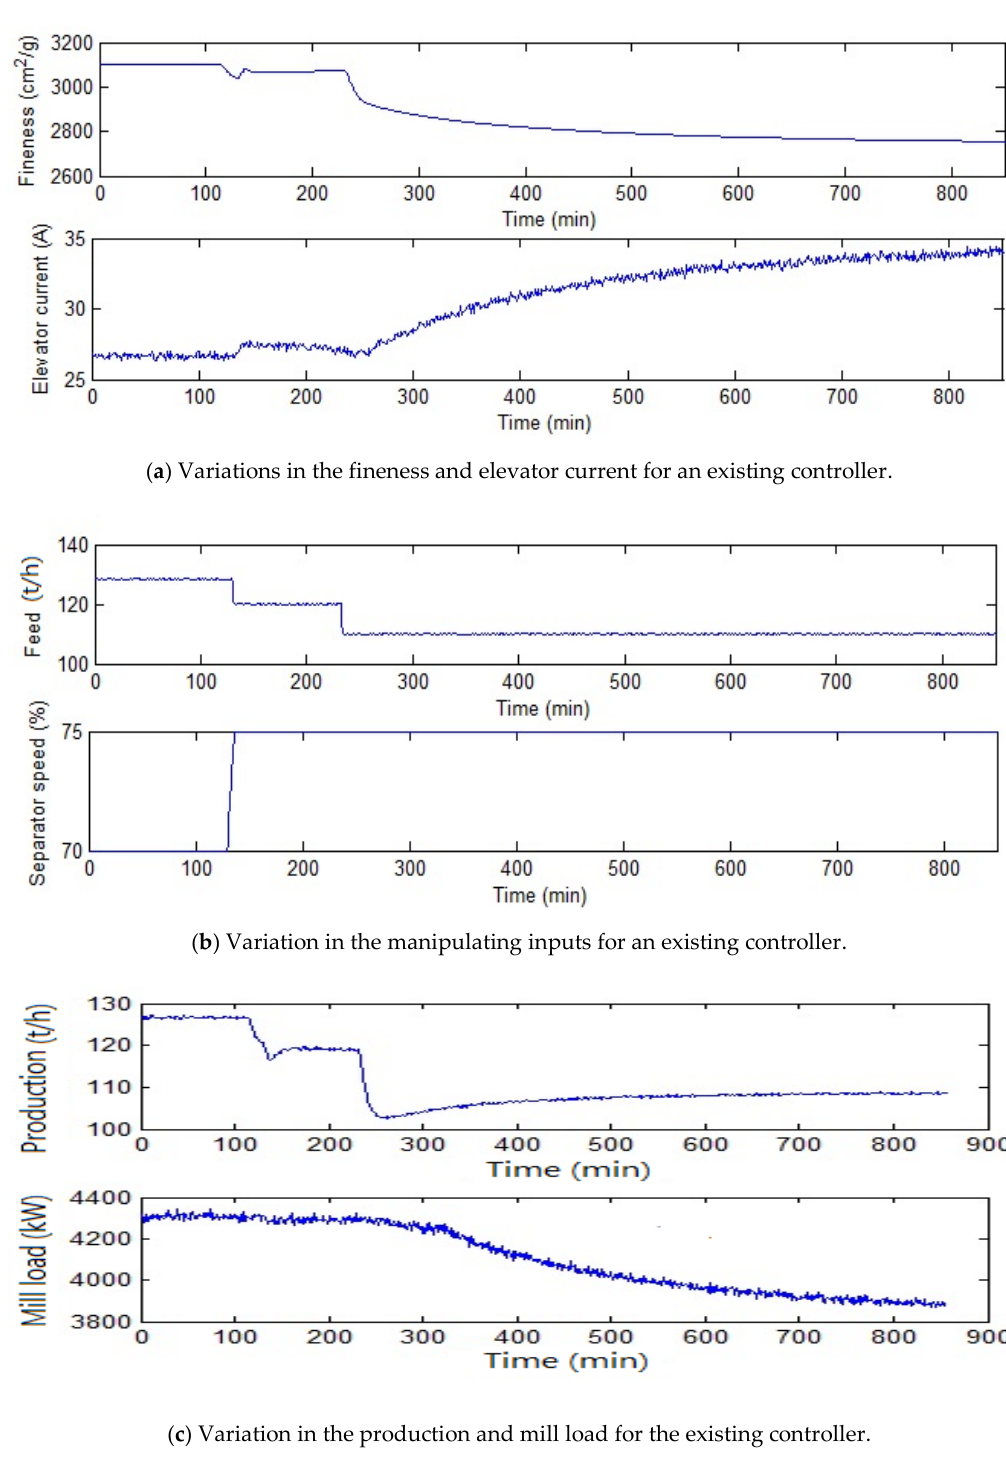
Figure 7. Variations in different process and manipulating variables in the presence of an existing controller in a real-time cement plant simulator.